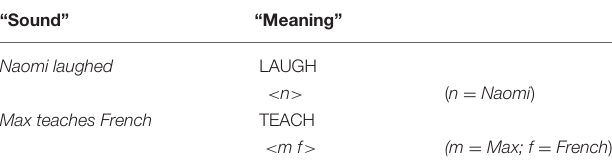
TABLE 1 | Representing sound and